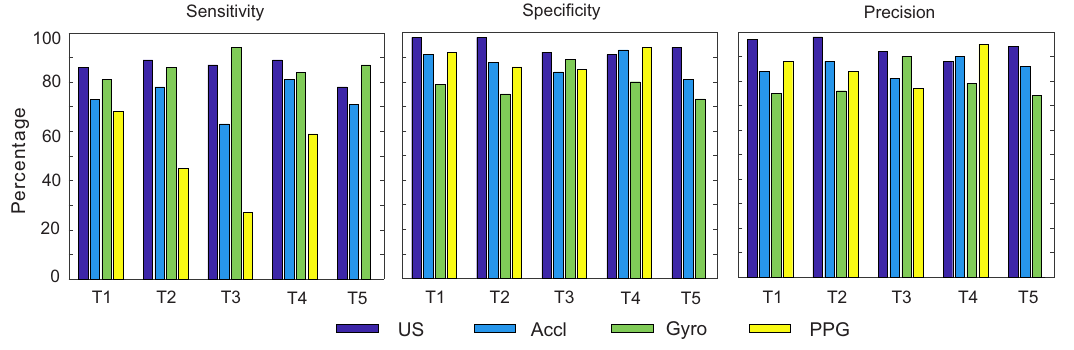
Figure 7. Graphical presentation of the values listed in Table